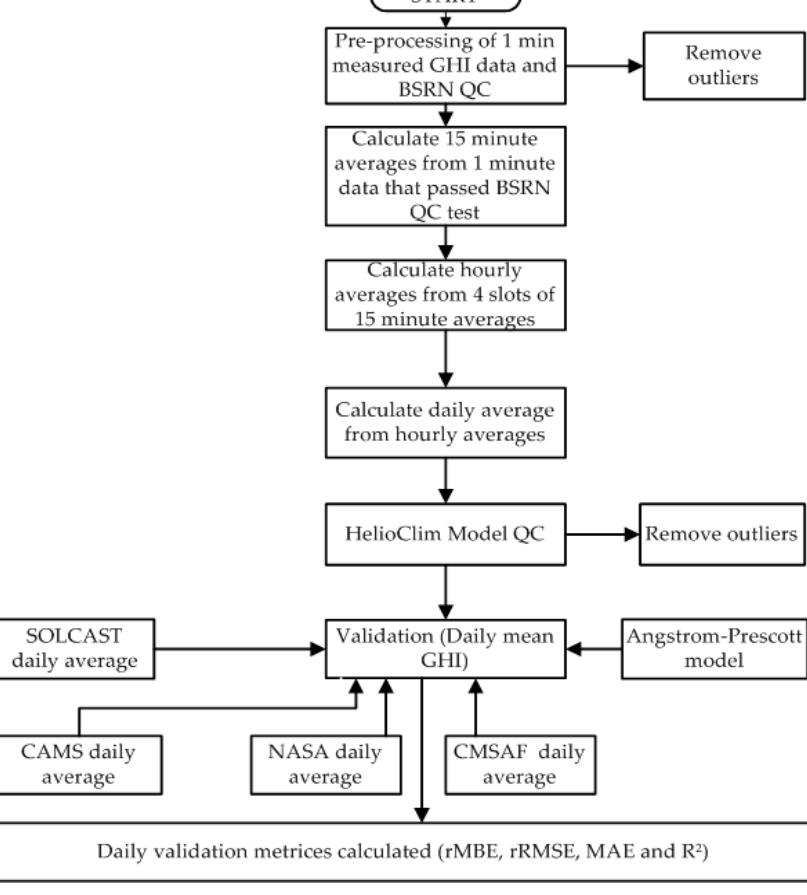
Figure 2. The study approach for the data quality control and quantitative assessment.